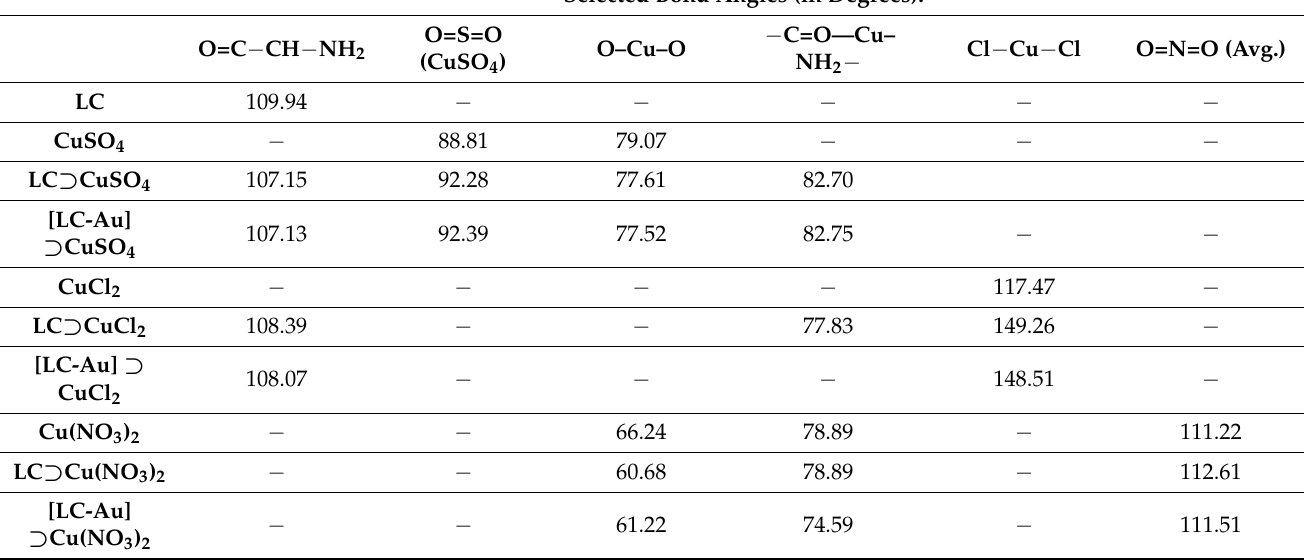
Table 5. DFT-calculated selected bond angles (in degrees) for the selected parameters of LC; LC-Au; CuSO 4 ; CuCl 2 ; and Cu(NO 3 ) 2 their complex (1:1) at the ω B97XD/LANL2DZ level of theory in the water solvent system. Selected Bond Angles (in